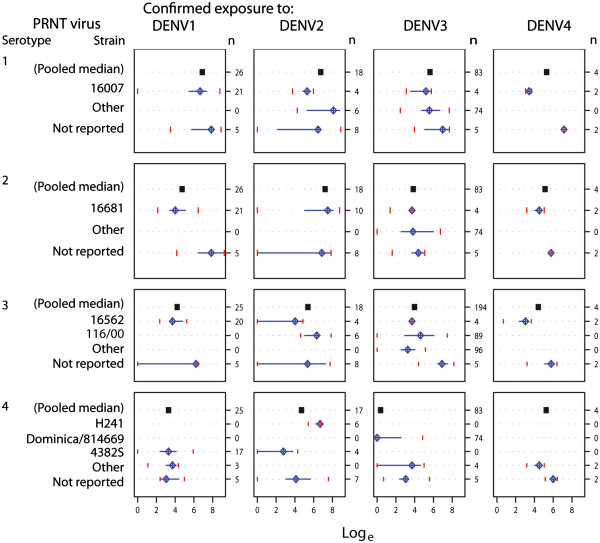
Matrices of natural logarithm-transformedPRNT titers from secondaryinfections stratified by strain. The “n” on the upper right of each exposure column represents the number of titers, filled squares indicate the pooled median log titer for all strains within that particular box, diamonds with crosshairs represent median log titers for strains, horizontal lines span the 25th-75th percentiles (interquartile range), and vertical lines mark the 5th and 95th percentiles of the data.